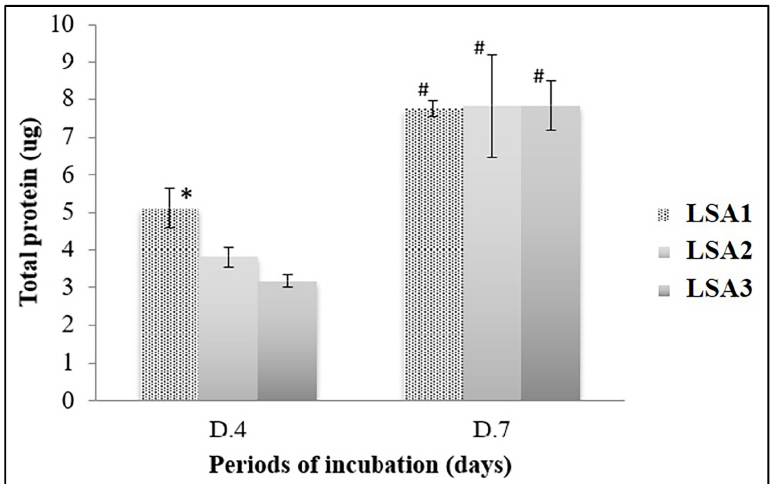
Figure 8. MG-63 protein contents. Total MG-63 protein production after the culture with lithium disilicate glass (LSA3) or lithium disilicate glass supplemented with aluminium at 0.5% mol (LSA1) and with aluminium at 1% mol (LSA2) for 4 (D.4) and 7 days (D.7), as determined with Bradford assay. The results were from a triplicate ( n = 3) experiment, and the statistical difference was tested when p < 0.05, which is represented by * (among the material types in each investigation period) and by # (between two investigation periods among the same material types).